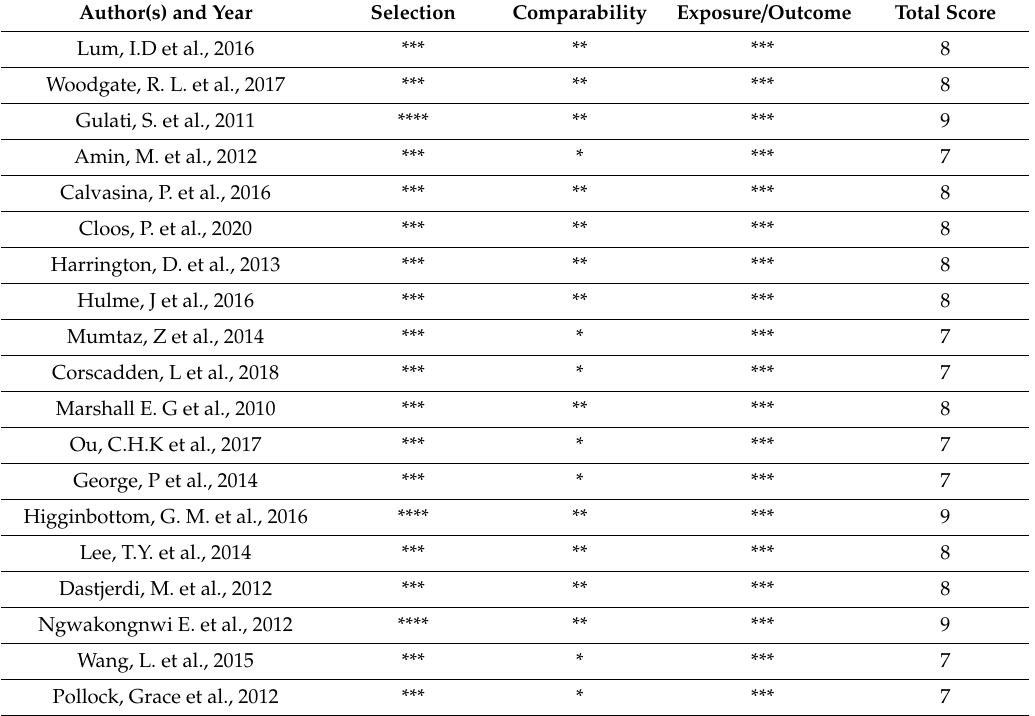
Table A1. NEWCASTLE-OTTAWA quality assessment scale for cross sectional